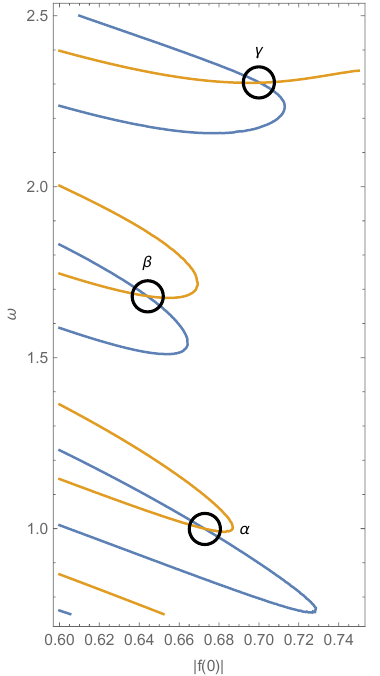
Figure 8 . Curves of vanishing real and imaginary parts of G ( !; j f (0) j ) in the d = 5 elliptic case. Three solutions were spotted, which we call (cid:11) , (cid:12) , (cid:13) in order of increasing ! . No other solutions were found outside this